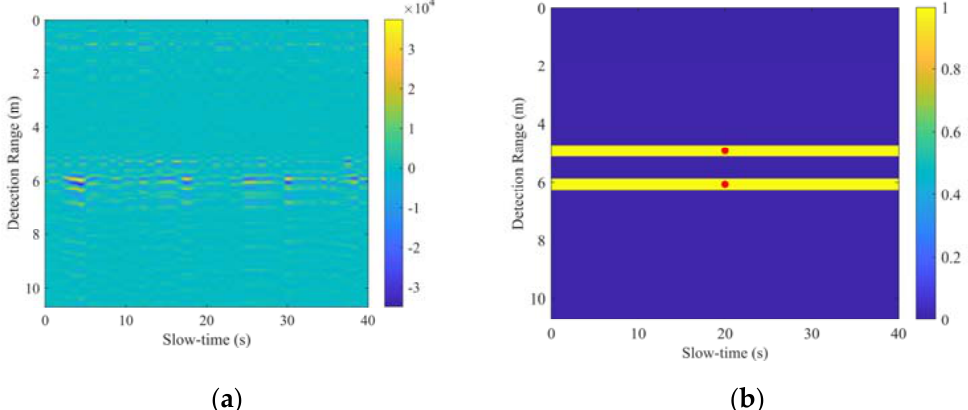
Figure 15. Results of Experiment 5.1: ( a ) range-slow-time matrix obtained after step A; ( b ) TPOIs extracted by CNN.